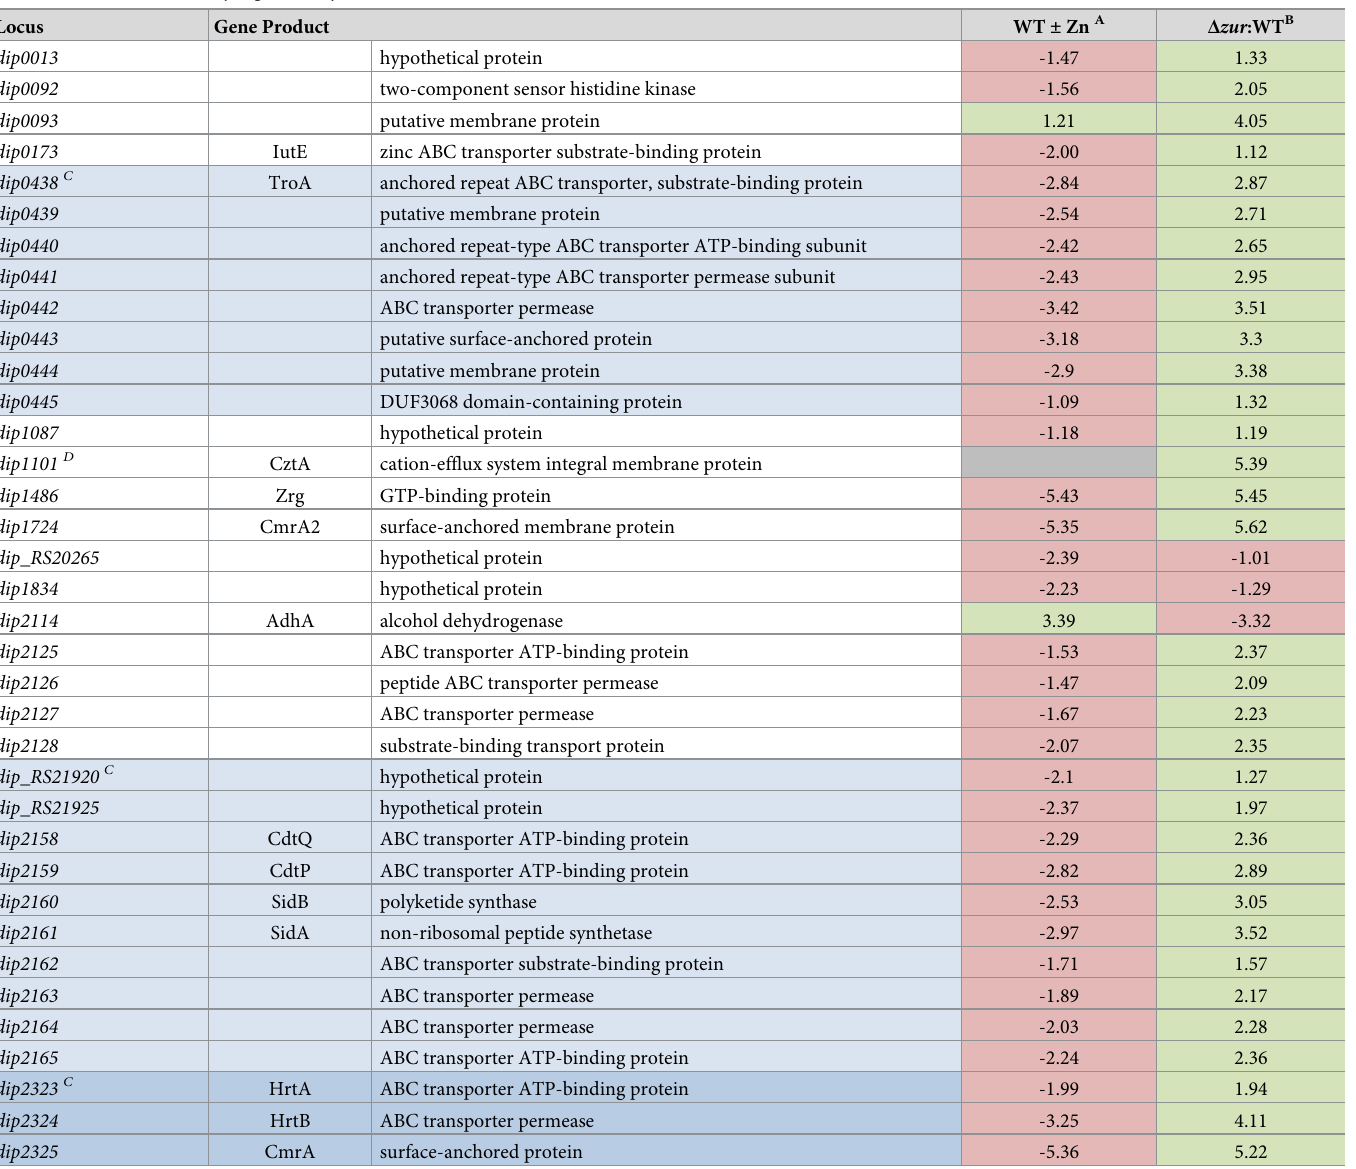
Table 1. Genes differentially regulated by zinc and